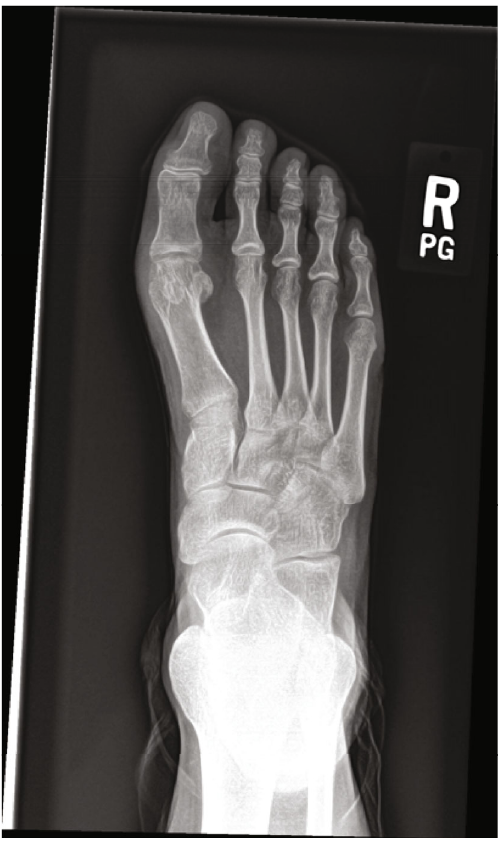
Figure 8: Anteroposterior radiograph of the right foot taken three years post-OCA implantation with complete resolution of hallux